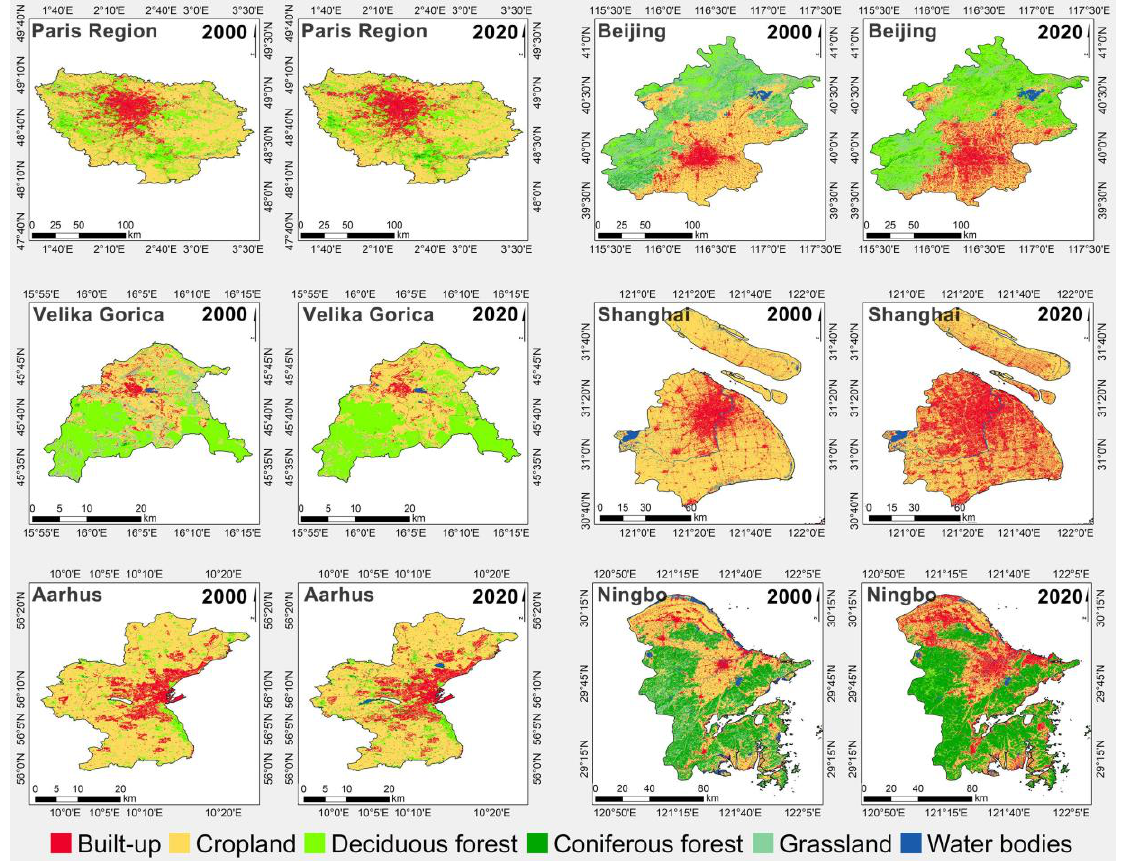
Figure 2. Monitoring land-cover changes in three European and three Chinese cities over the last 20 years. Data modified after Banzhaf et al., 2021